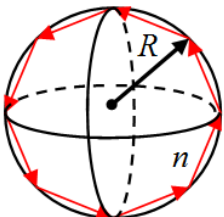
Figure 1. Ray optics description of MDR in a sphere.